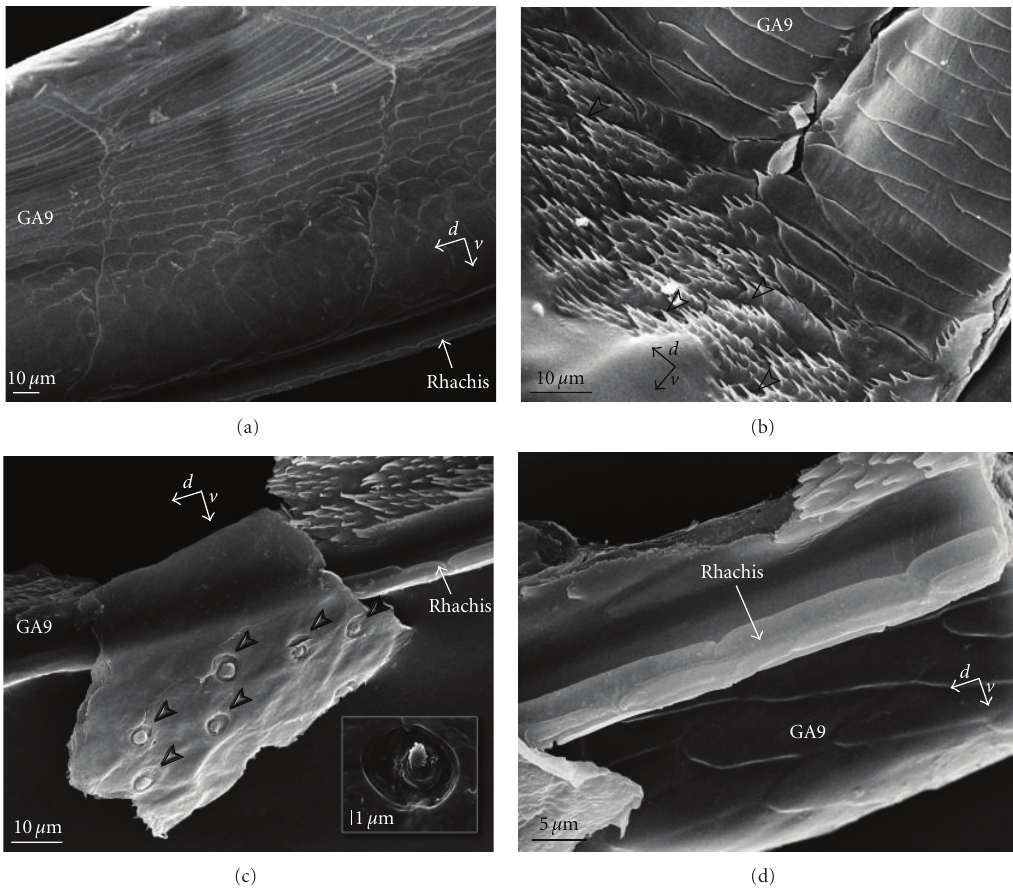
Figure 3: SEM micrographs of the inside surface of the 9th gonapophysis of Tricholepidion gertschi : (a) transverse sculptured field in the middle part of the gonapophysis, with longitudinal ridges and wrinkles dorsally and squamous microsculpture ventrally; (b) transverse sculptured field in the subapical part of the gonapophysis, with longitudinal ridges and wrinkles, ventrally replaced by spine-bearing scales and microtrichia; (c) fragment of the integument turned inside out to show the density of dome-shaped sensilla (underside surface of the sensillum is enlarged in inset); (d) rhachis. Arrowheads indicate dome-shaped sensilla. GA9, the gonapophyses of the 9th segment. d and v : distal and ventral directions,